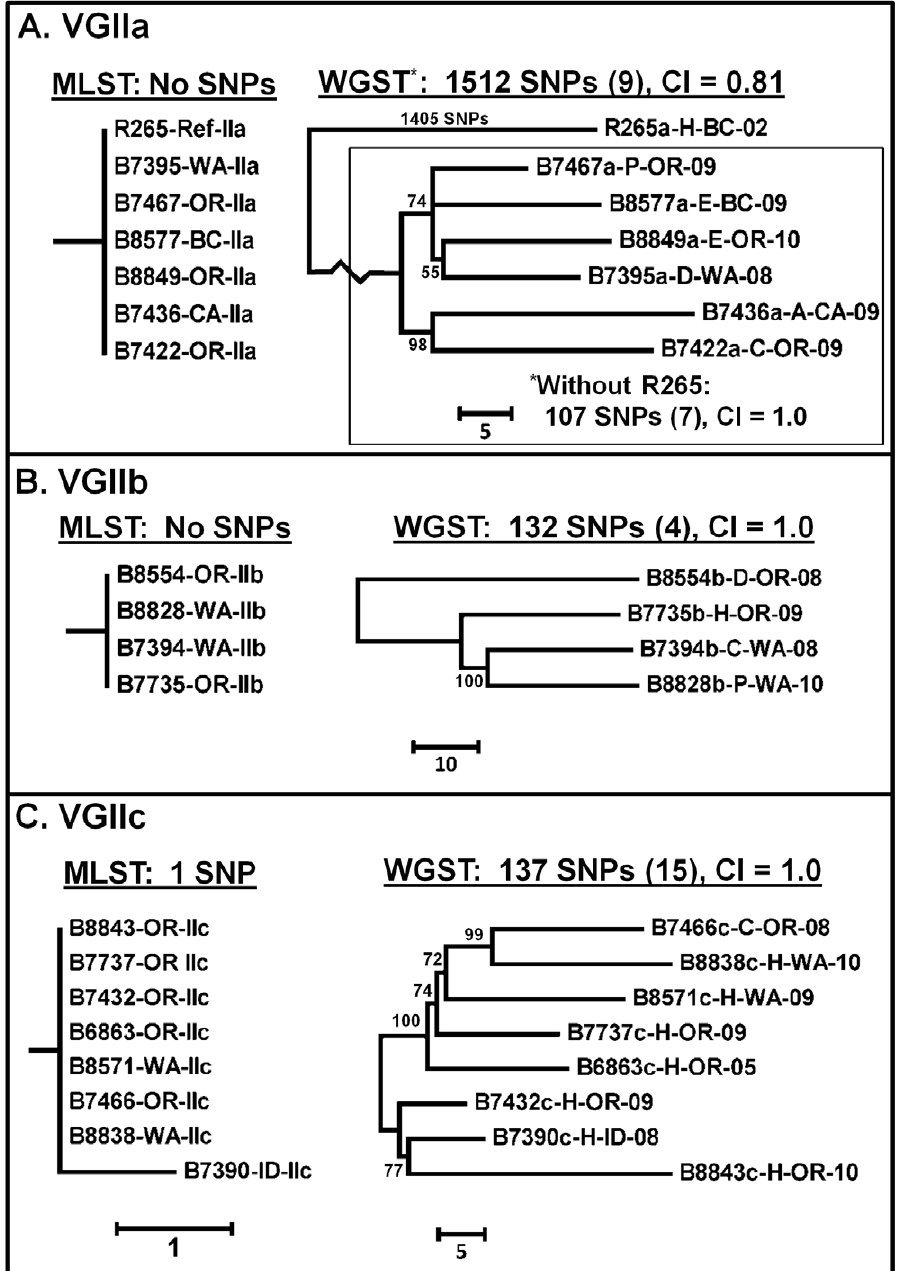
Figure 3. Comparison of MLST and WGST analysis of VGIIa, VGIIb and VGIIc C.gattii isolates. Maximum parsimony phylogenetic analysis was performed in MEGA4 on MLST and WGST SNP data from VGIIa (panel A), VGIIb (panel B) and VGIIc (panel C) genomes. Scale bars indicate relative branch lengths for each analysis. The R265 whole genome sequence was used as the reference for SNP discovery (R265a-H-BC-02). VGIIa (panel A) analysis is shown both with and without R265, VGIIb and VGIIc shown only without R265. The numbers of SNPs included in each analysis is indicated. The consistency index value (CI) was calculated in MEGA4. Meaning of taxa nomenclature is described in legends for Figures 1 (MLST) and 2 (WGST). Trees shown are mid-point rooted, bootstrap values less than 50% are not